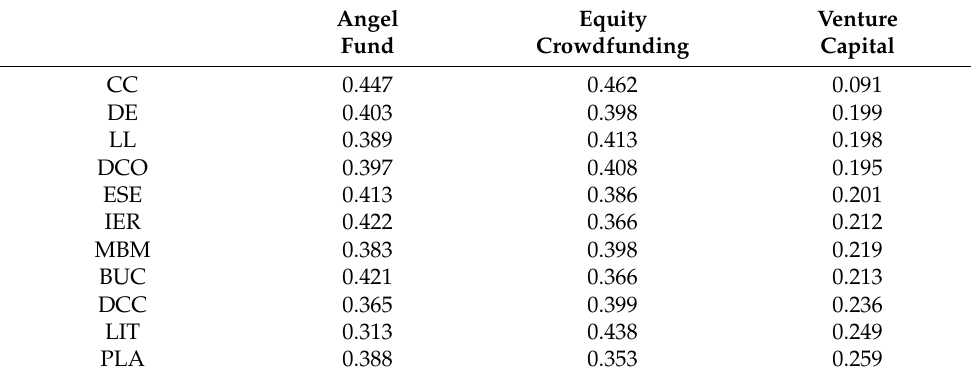
Table 3. Eigenvectors (weights) of 11 factors for alternatives.